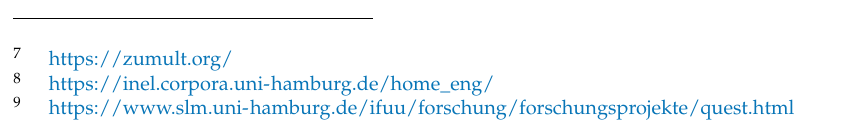
Figure 1. An audio-visual collection: the spoken language